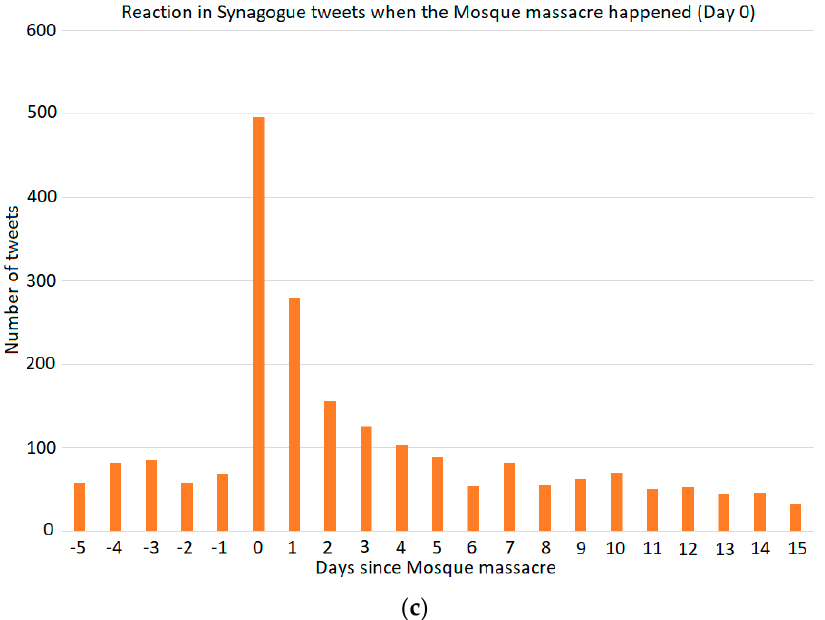
Figure 4. Re-invigoration of discussion in reaction to new violent events. ( a ) Reaction of Church massacre tweets when Synagogue massacre started; ( b ) reaction of Church massacre tweets when mosque massacre started; ( c ) reaction of synagogue massacre tweets when mosque massacre started.